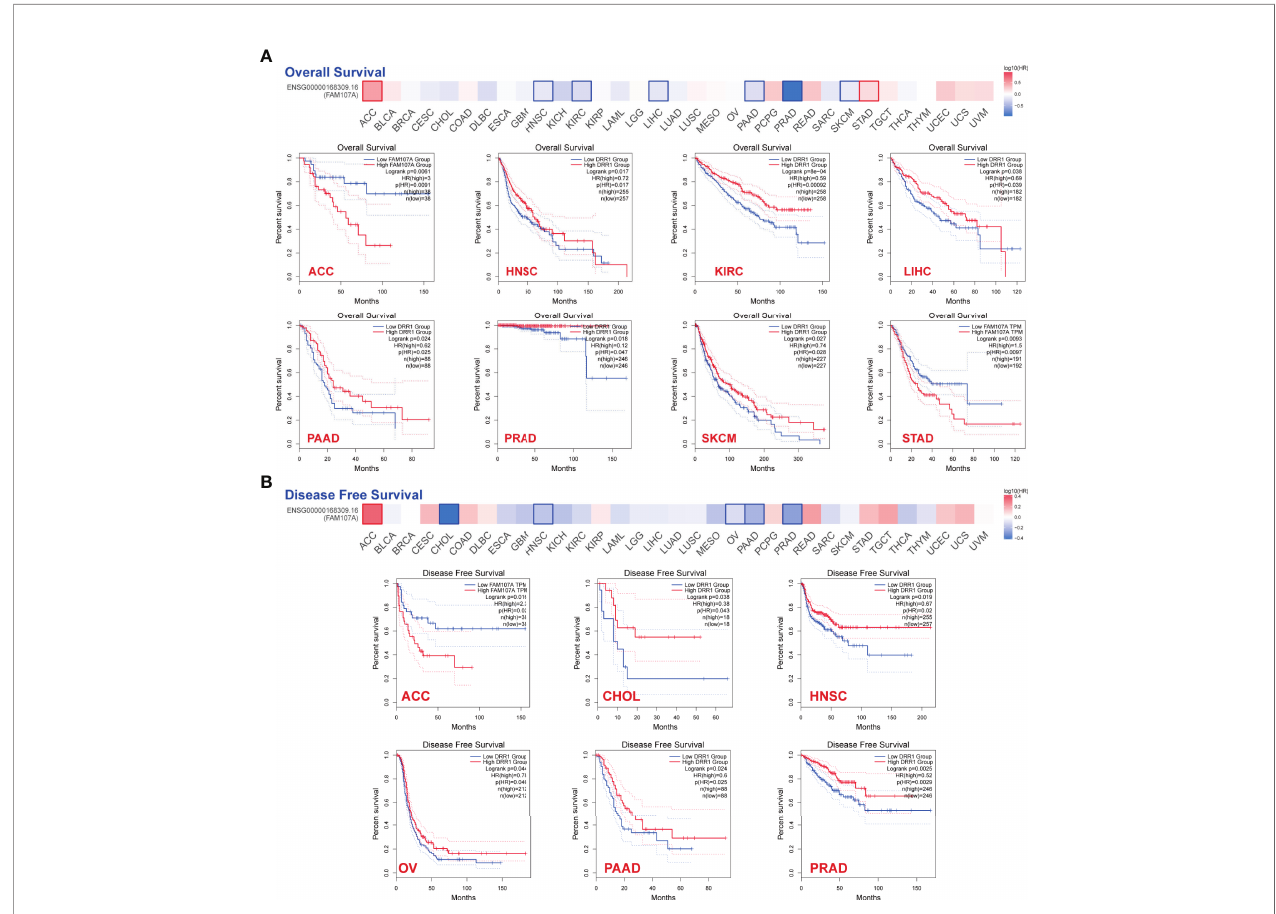
FIGURE 2 | Correlation between expression level of FAM107A and survival prognosis of cancers in TCGA. Overall survival (A) and disease-free survival (B) analyses of FAM107A gene expression in different tumors from TCGA database were performed using GEPIA2 tool. The survival map and Kaplan-Meier curves with positive results are